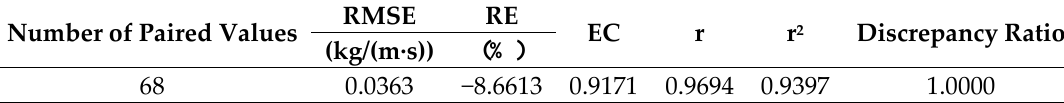
Table 1. Statistical criteria values of Nestos River (manual